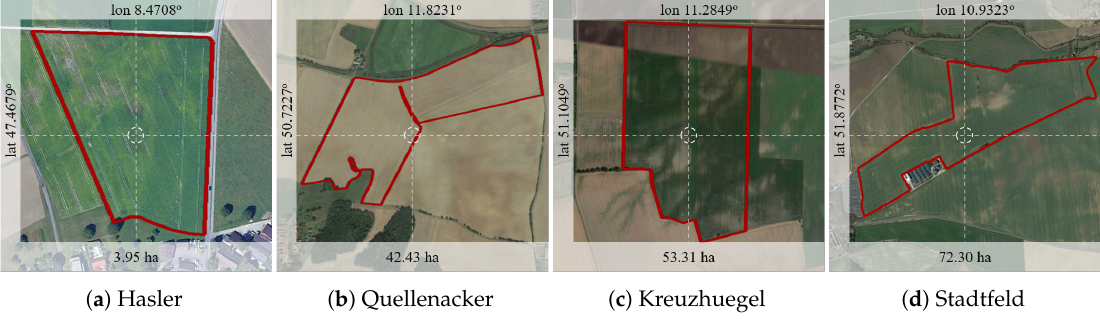
Figure 1. Four investigated fields, Hasler (Switzerland), Quellenacker (Germany), Kreuzhuegel (Germany) and Stadtfeld (Germany), are given with their location and